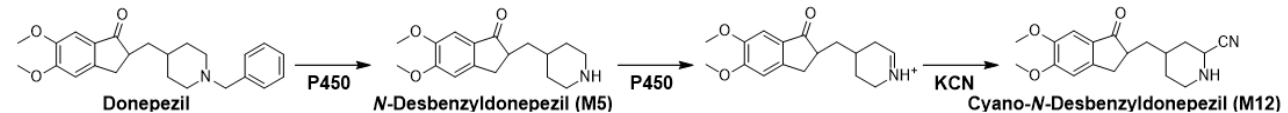
Figure 6. Proposed bioactivation mechanism of the piperidine ring of donepezil and the formation of a cyano adduct.